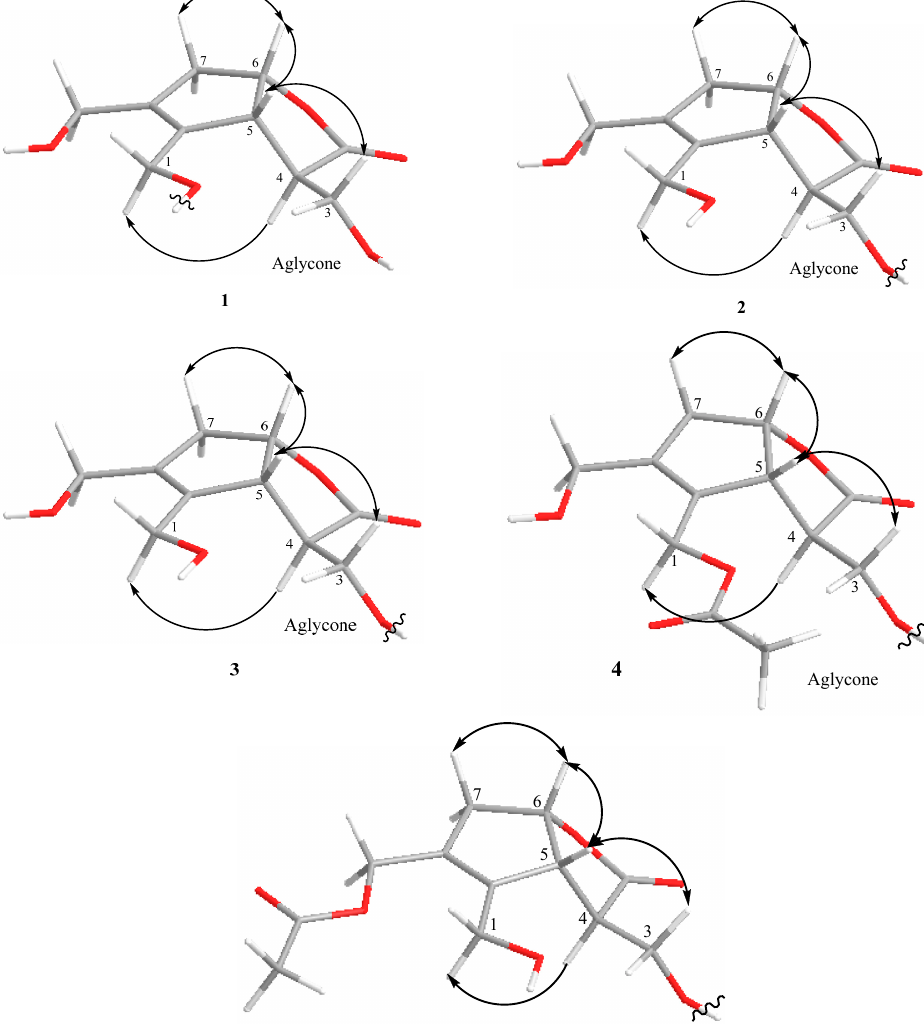
Figure 3. Key NOESY correlations of 1 – 5 .